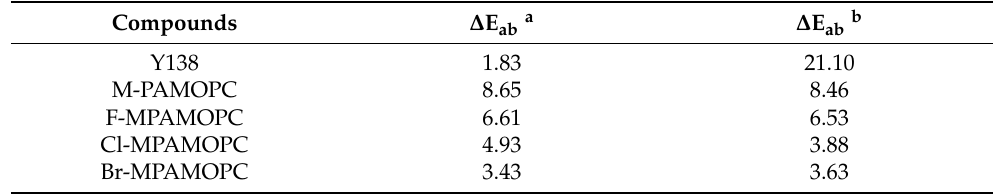
Table 3. The color difference values of the new yellow materials after thermal stability a and solvent resistance b tests.